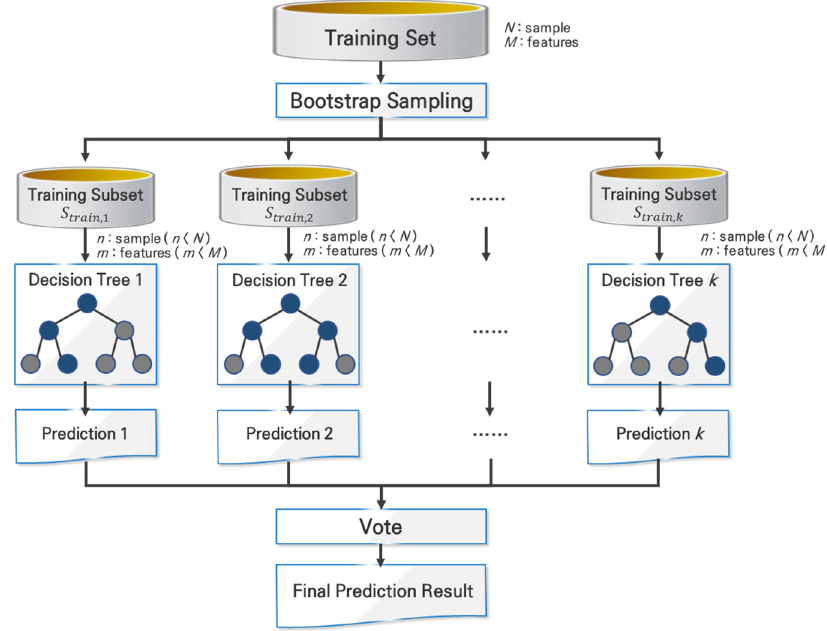
Figure 1. Architecture of a random forest.